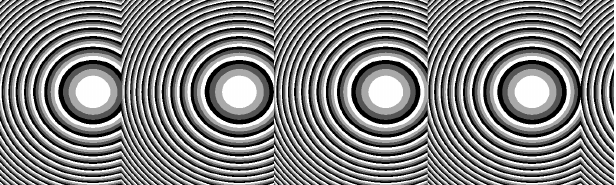
Figure 4. Example of DOE using an off-axis Fresnel lens pattern (i.e., focusing with an axial shift that can be integrated) for four positions.